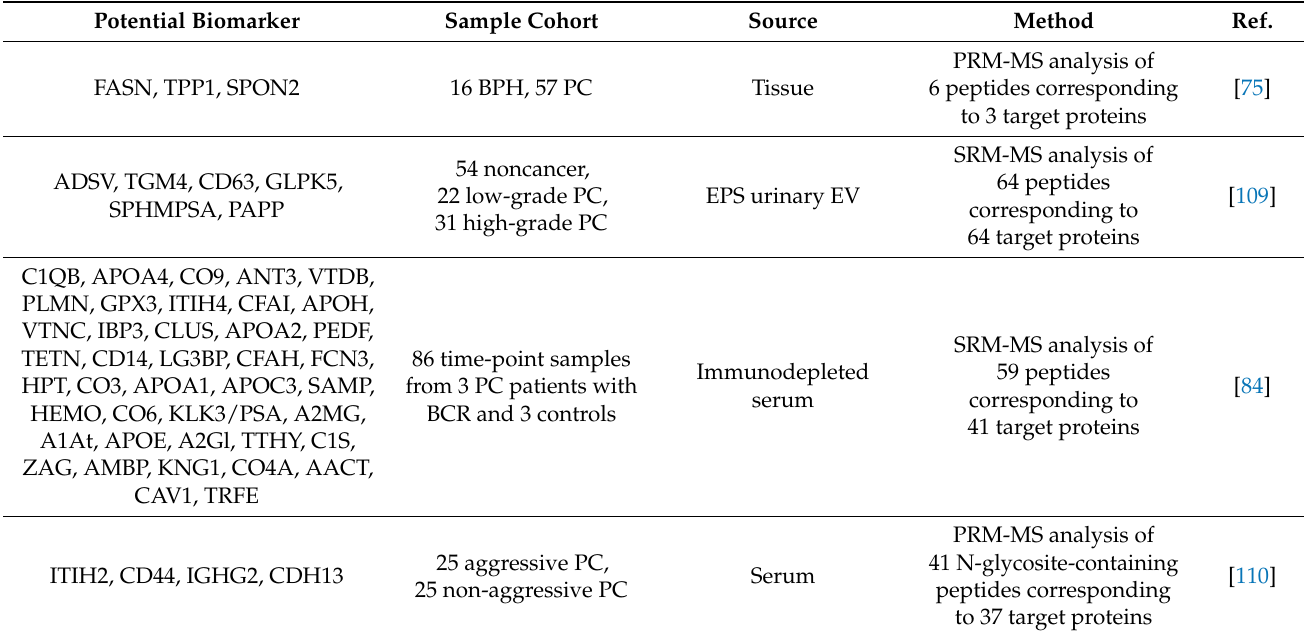
Table 2. List of MS-based targeted proteomics validation studies of candidate PC protein markers. Potential